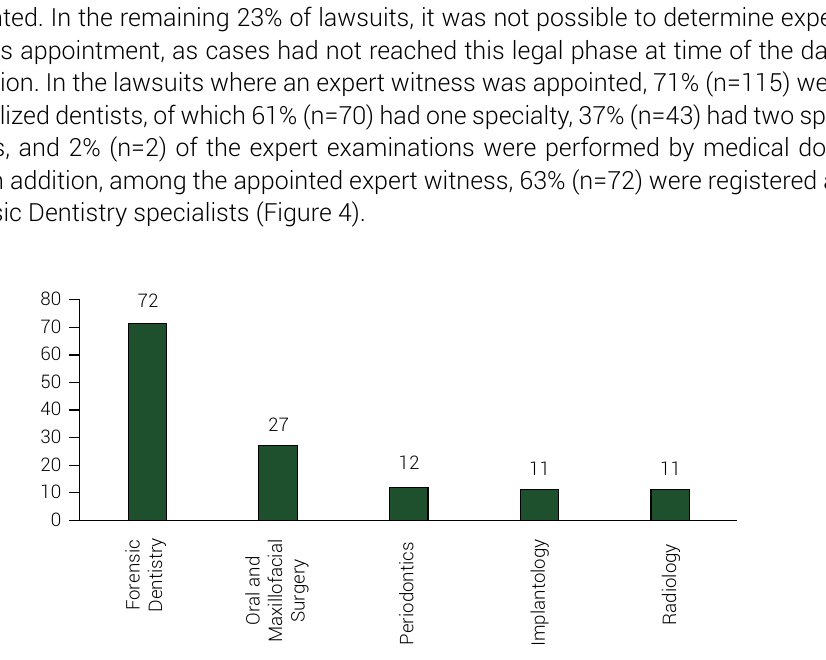
Figure 4. Specialties of expert witnesses appointed in lawsuits against dentists involving dental malpractice litigance, 2012-2017, São Paulo, SP, Brazil.